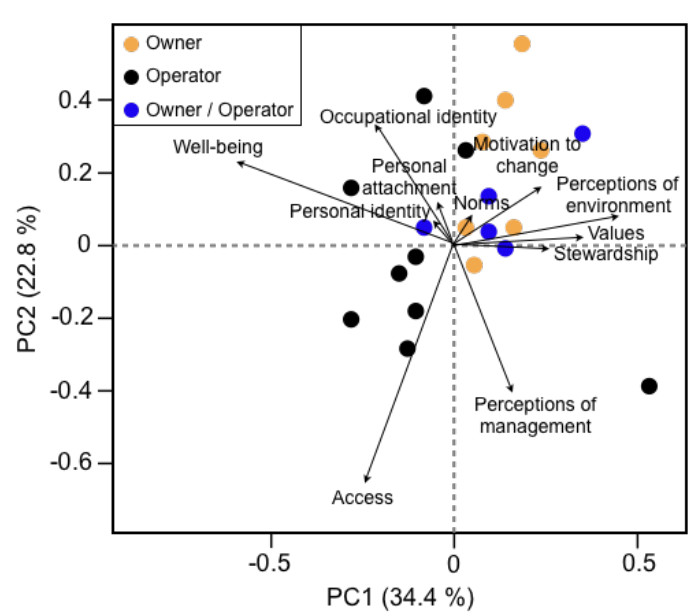
Figure S1. PCA of the 11 susceptibility indicators at the individual level.